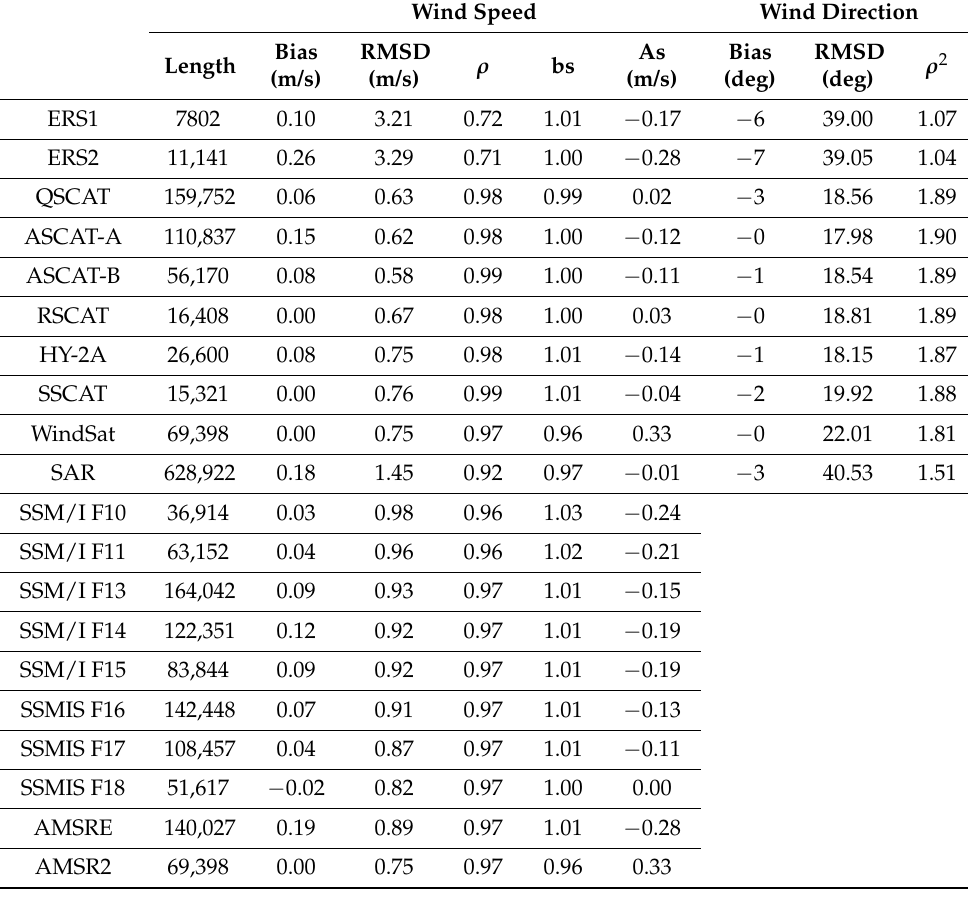
Table 2. Statistical parameters aiming at the characterization of the comparisons between NDBC buoy and remotely sensed wind speed and direction data. They are calculated from available collocated data occurring along the period 1992 through